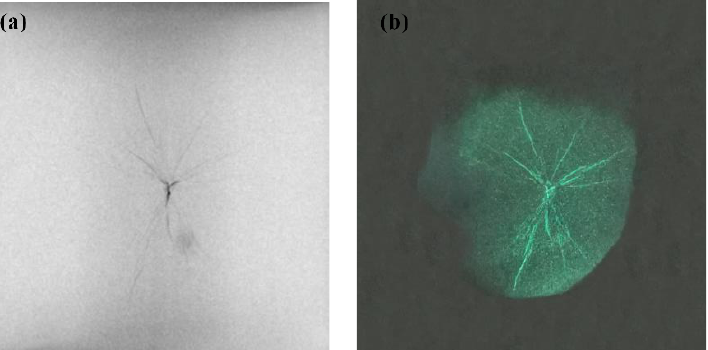
Figure 8. Comparison between CT scanned results and the result obtained using CFS technique: ( a ) CT scanned image; ( b ) Fluorescent stained image.